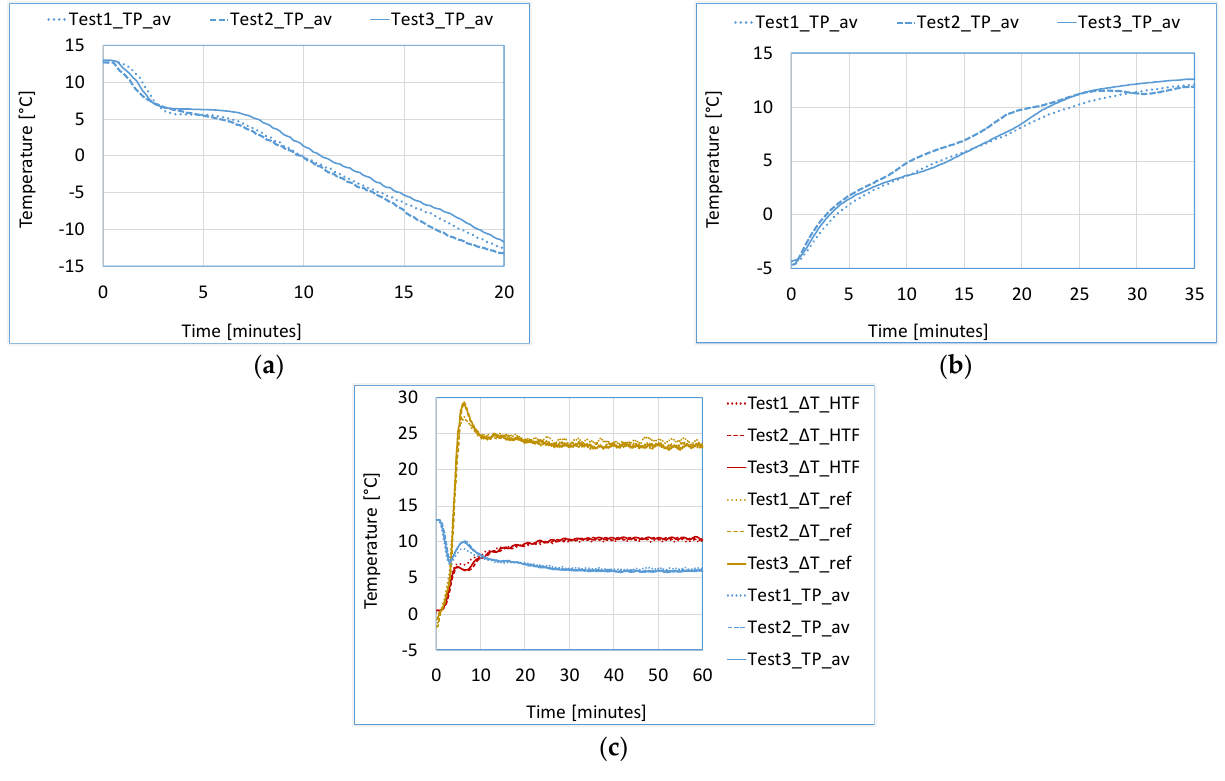
Figure 3. Repeatability and robustness of the results for the ( a ) charging process, ( b ) discharging process, and ( c ) three-fluids HEX mode.